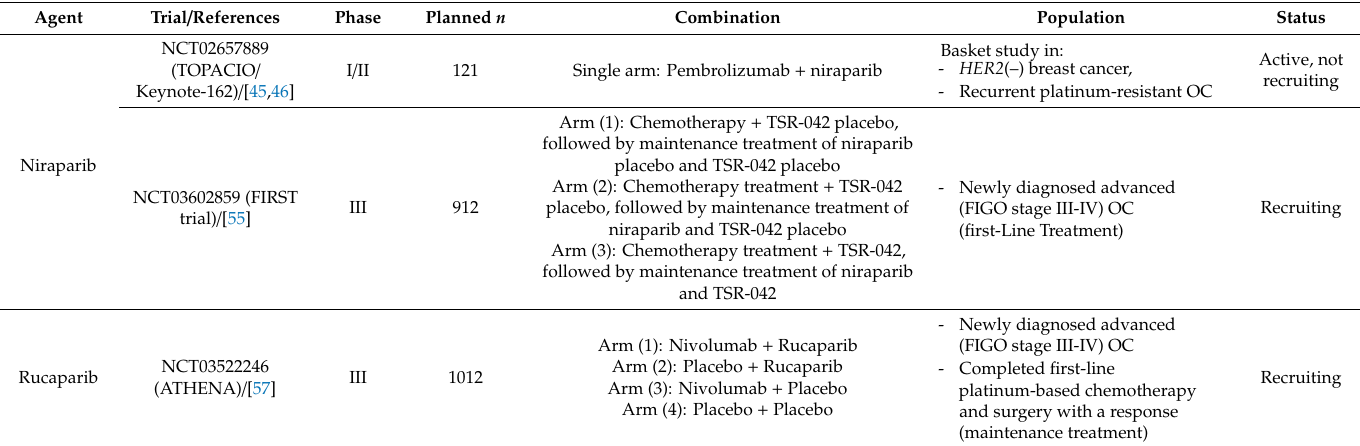
FIGO: International Federation of Gynaecology and